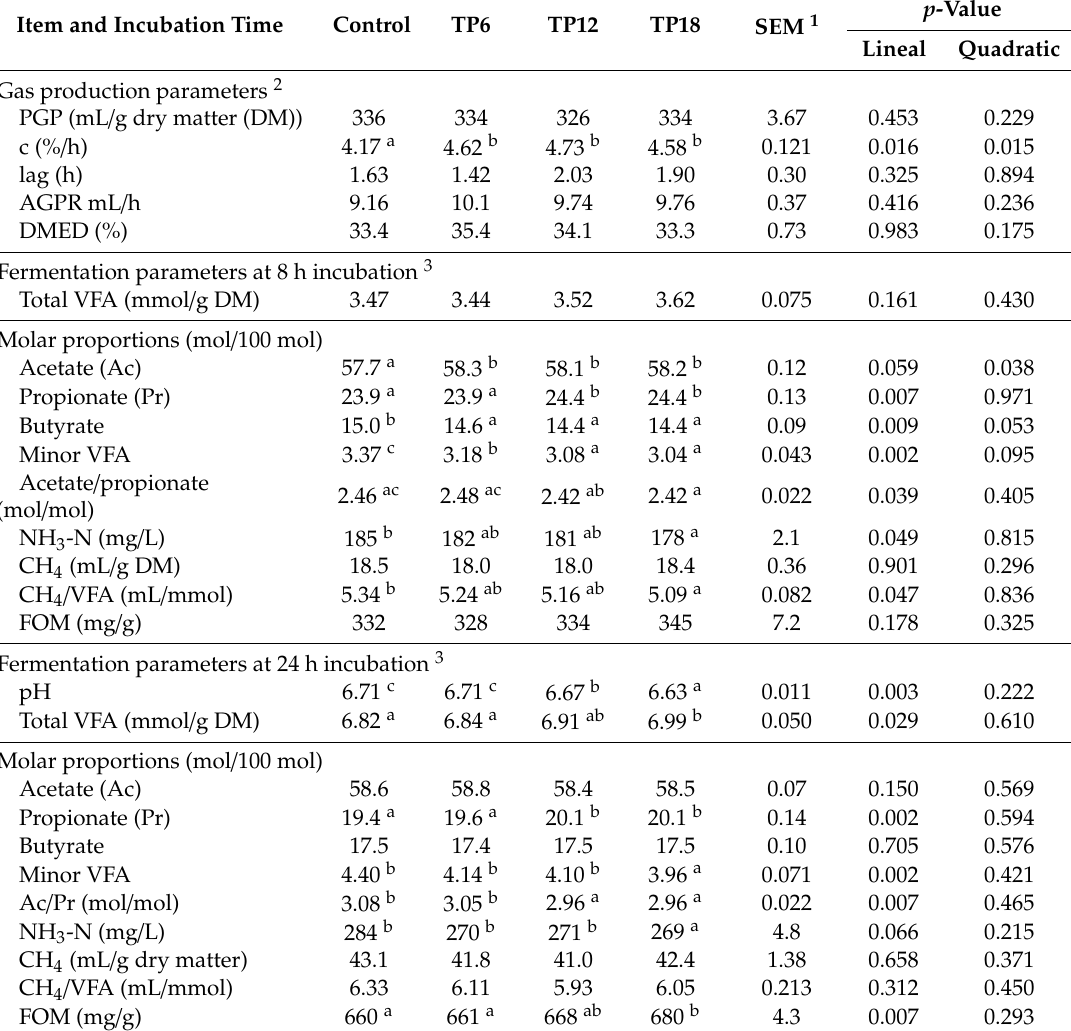
Table6. Gasproductionparametersandfermentationparametersafter8and24hofin vitrofermentation of diets containing increased amounts of tomato pomace incubated in batch cultures of mixed rumen microorganisms 1